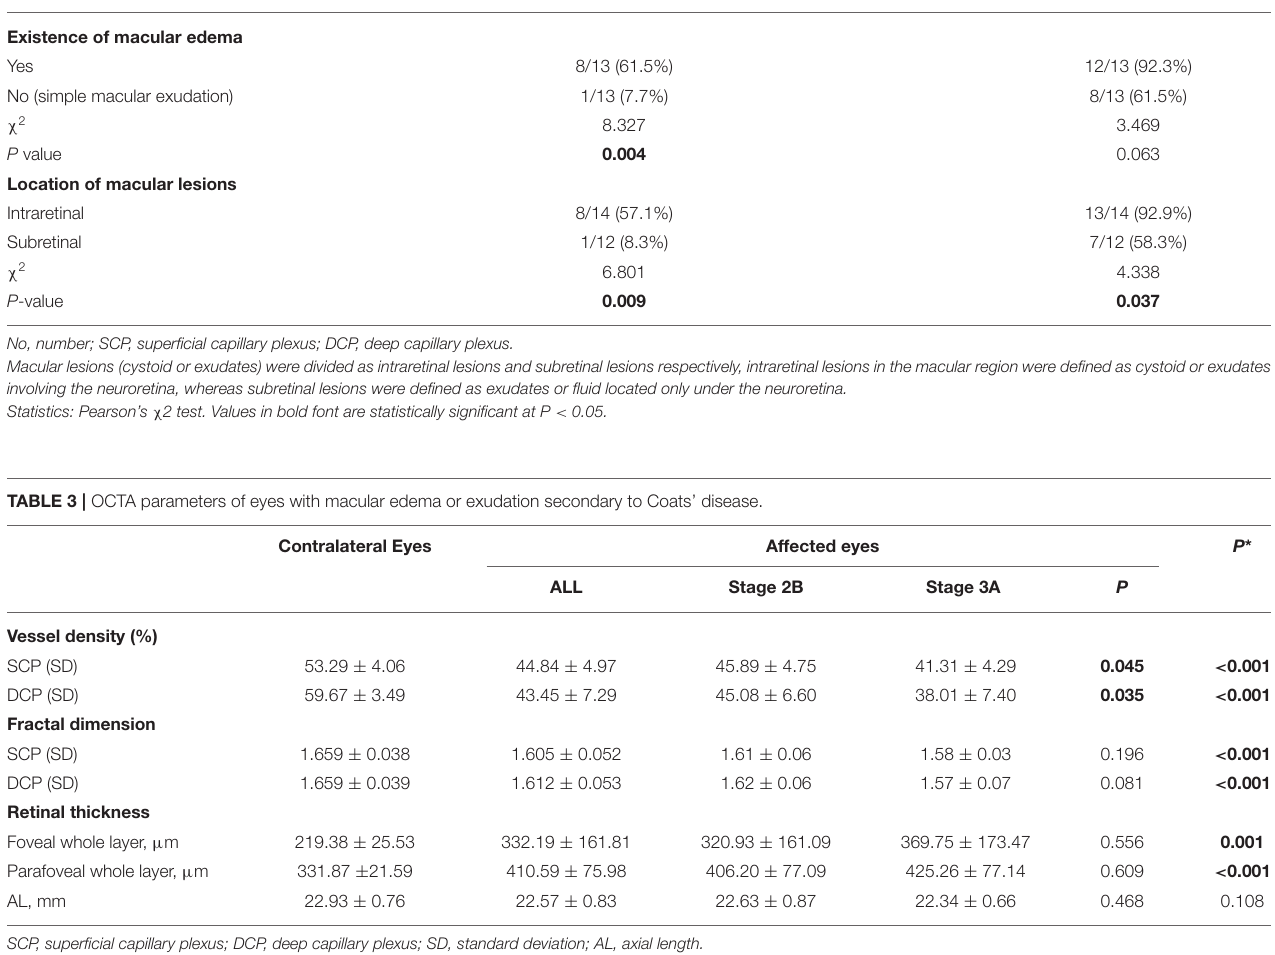
Frontiers in Medicine |